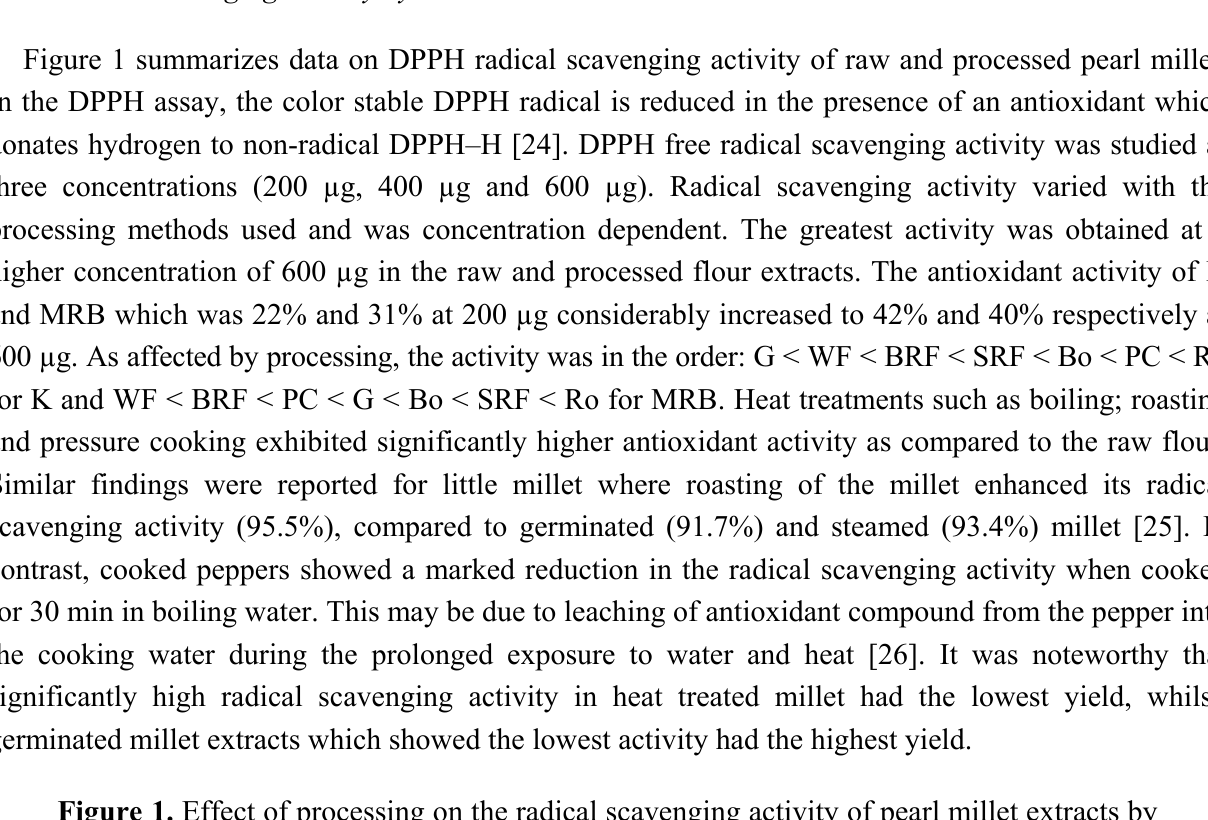
Figure 1. Effect of processing on the radical scavenging activity of pearl millet extracts by